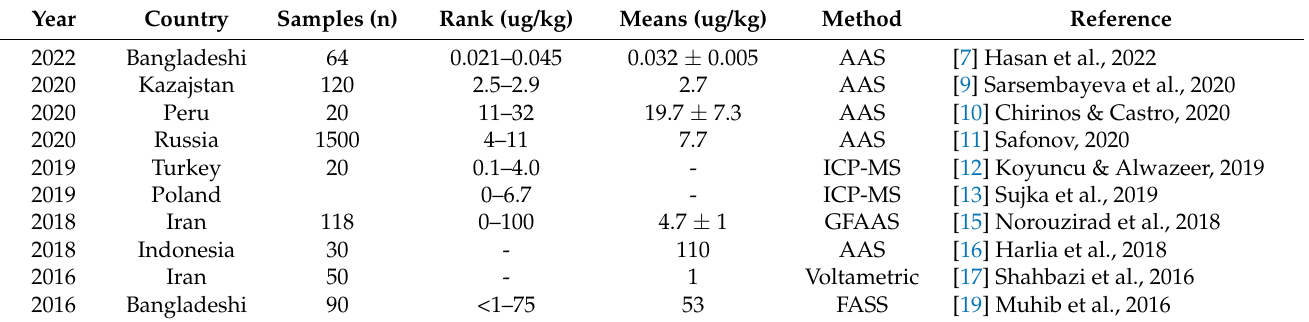
Table 2. Cd content in whole milk samples from various countries